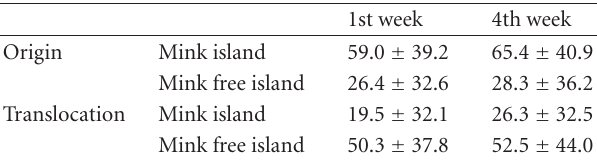
Table 5: Mean and SD of the proportion (in %) of localisations of voles in juniper habitats during first week and fourth week after